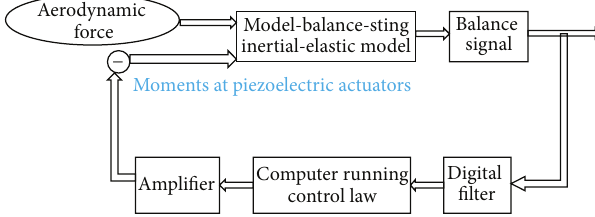
Figure 2: Schematic diagram of active sting damper